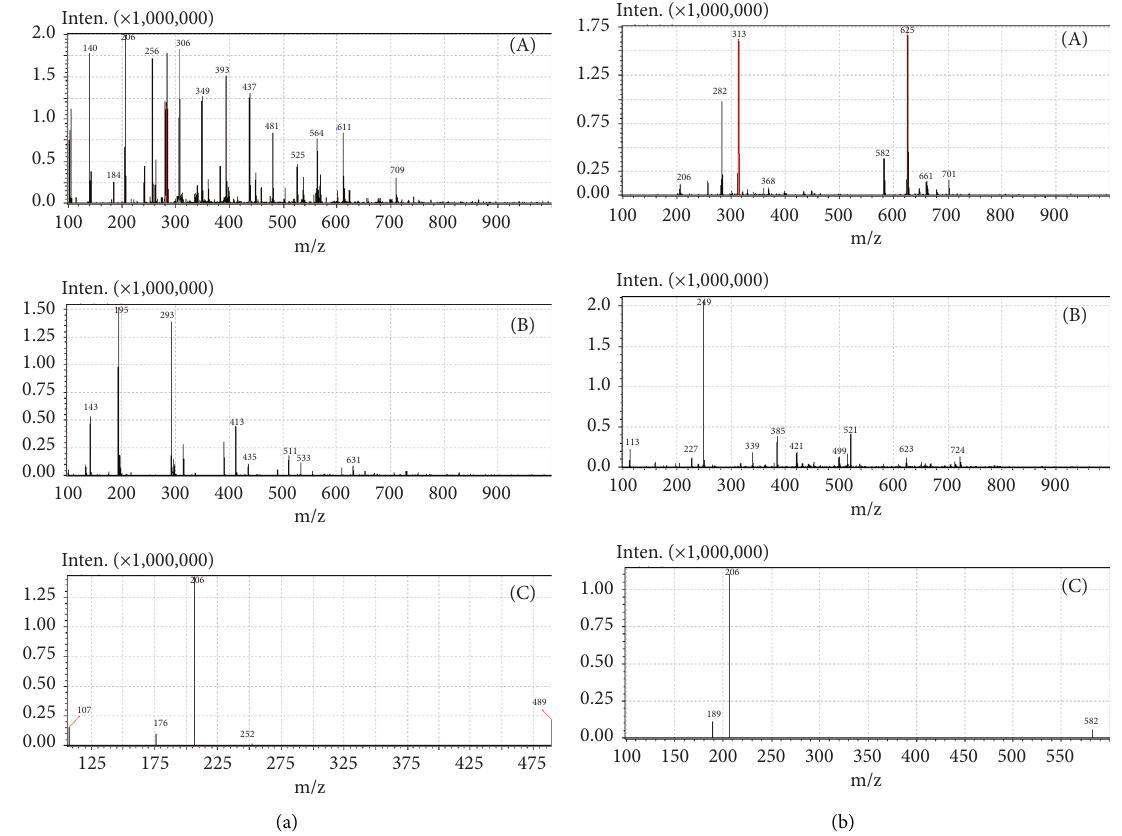
Figure 2: Full-scan mass spectrum of (a) liensinine and (b) dauricine: (A) ESI positive, (B) ESI negative, and (C) product ion scan.